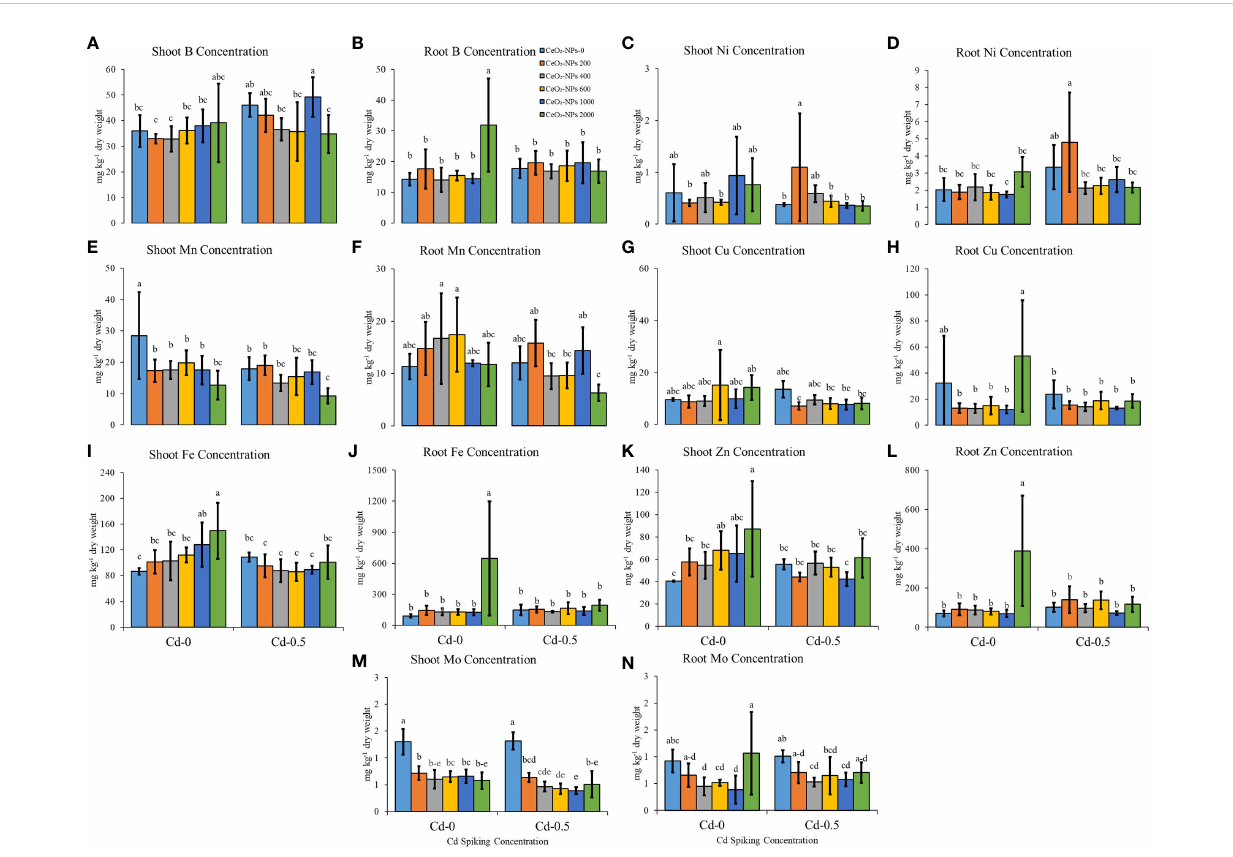
FIGURE 5 Effect of CeO 2 -NPs applied at 200, 400, 600, 1000 and 2000 mg kg -1 dry sand alone and in combination with 0.5 mg kg -1 Cd on maize Cd and Ce contents. (A) shoot b (mg kg -1 dry weight), (B) root b (mg kg -1 dry weight); (C) shoot ni (mg kg -1 dry weight), (D) root ni (mg kg -1 dry weight); (E) shoot mn (mg kg -1 dry weight), (F) root mn (mg kg -1 dry weight); (G) shoot cu (mg kg -1 dry weight), (H) root cu (mg kg -1 dry weight); (I) shoot fe (mg kg -1 dry weight), (J) root fe (mg kg -1 dry weight); (K) shoot zn (mg kg -1 dry weight). (L) root zn (mg kg -1 dry weight); (M) shoot mm (mg kg -1 dry weight), (N) root mn (mg kg -1 dry weight). The graphs are of mean ( n = 4) ± standard deviation. Letters shown pair wise comparison via Least Signi fi cant Difference (LSD) at p ≤